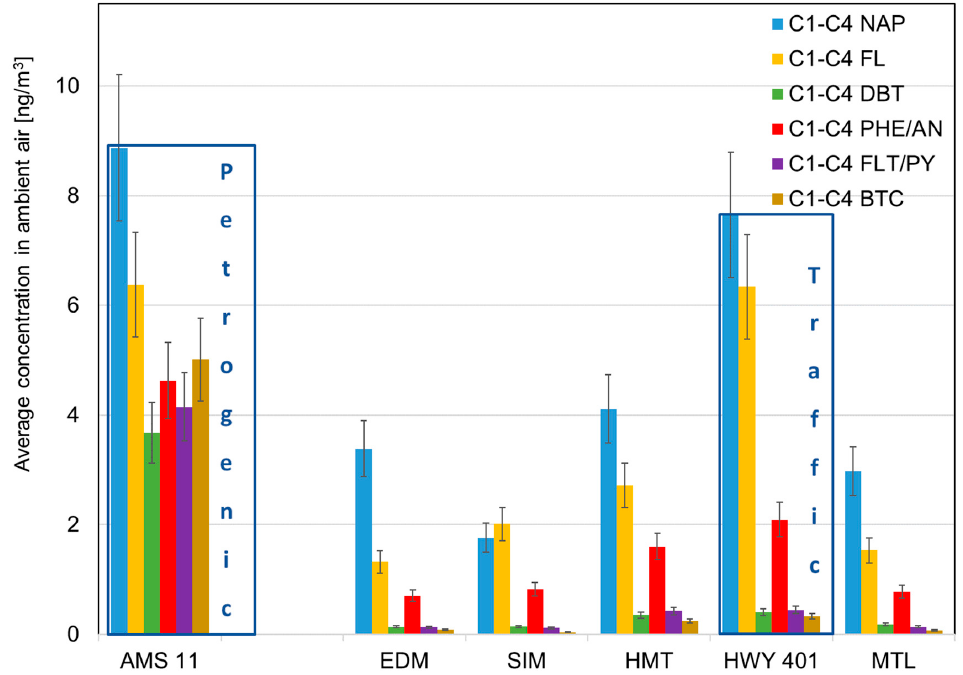
Figure 5. Characteristic profiles of individual alkyl-PAH classes by